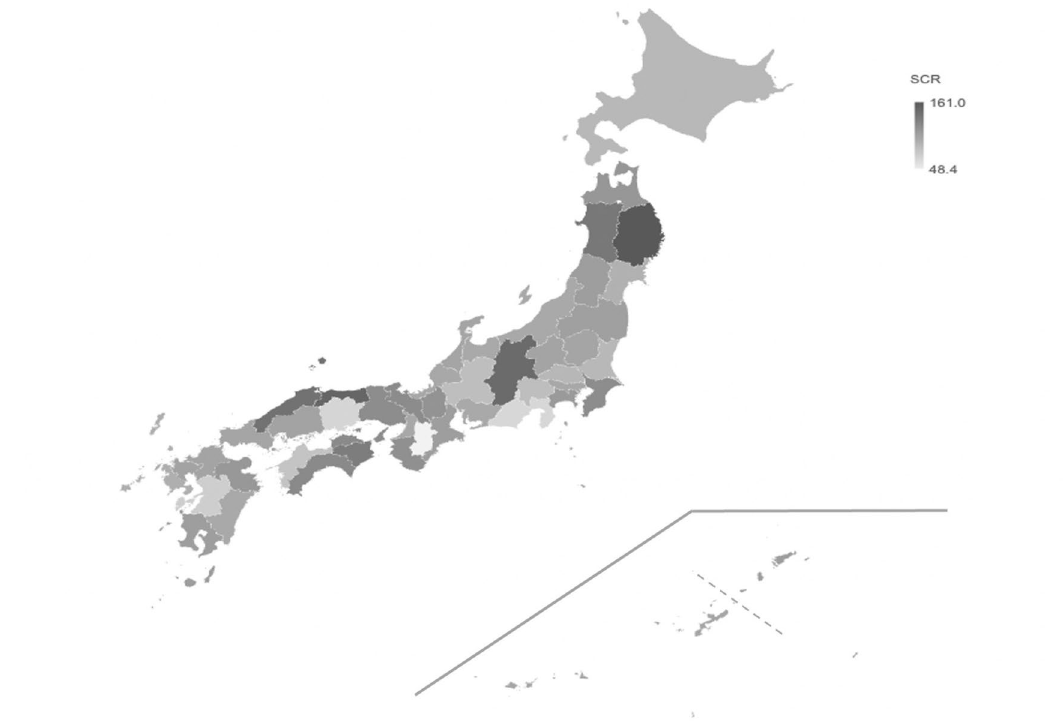
Figure 1. Intensity map showing SCR for each prefecture. The darker the color, the larger the SCR. A part of Kagoshima prefecture and Okinawa prefecture (the lower right of the figure) is different from the actual